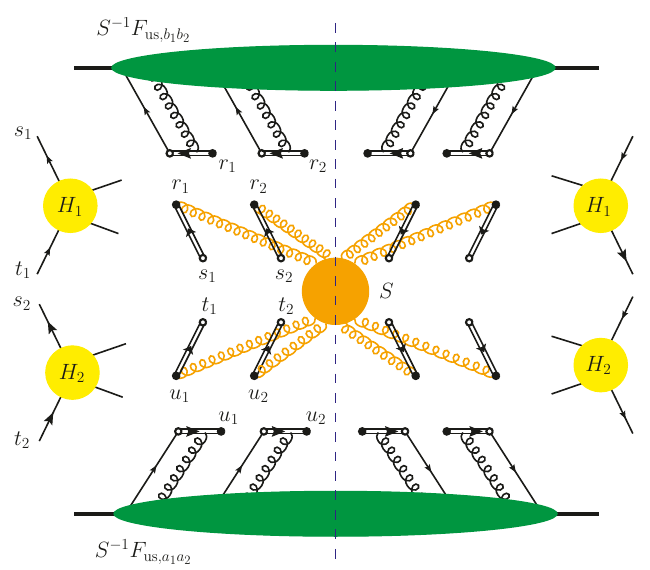
Figure 3. Graphical representation of colour index contractions in the factorised double dijet cross section. The indices in this figure correspond to the ones given in (4.51). The corresponding primed indices in the complex conjugate part of the graph are not